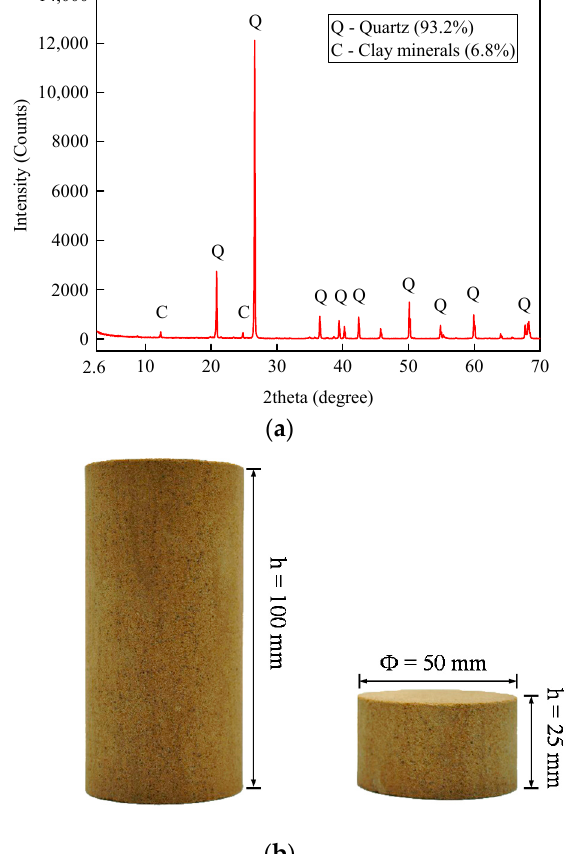
Figure 1. Specimen preparation. ( a ) Mineralogical compositions of sandstone. ( b ) Sandstone specimens.